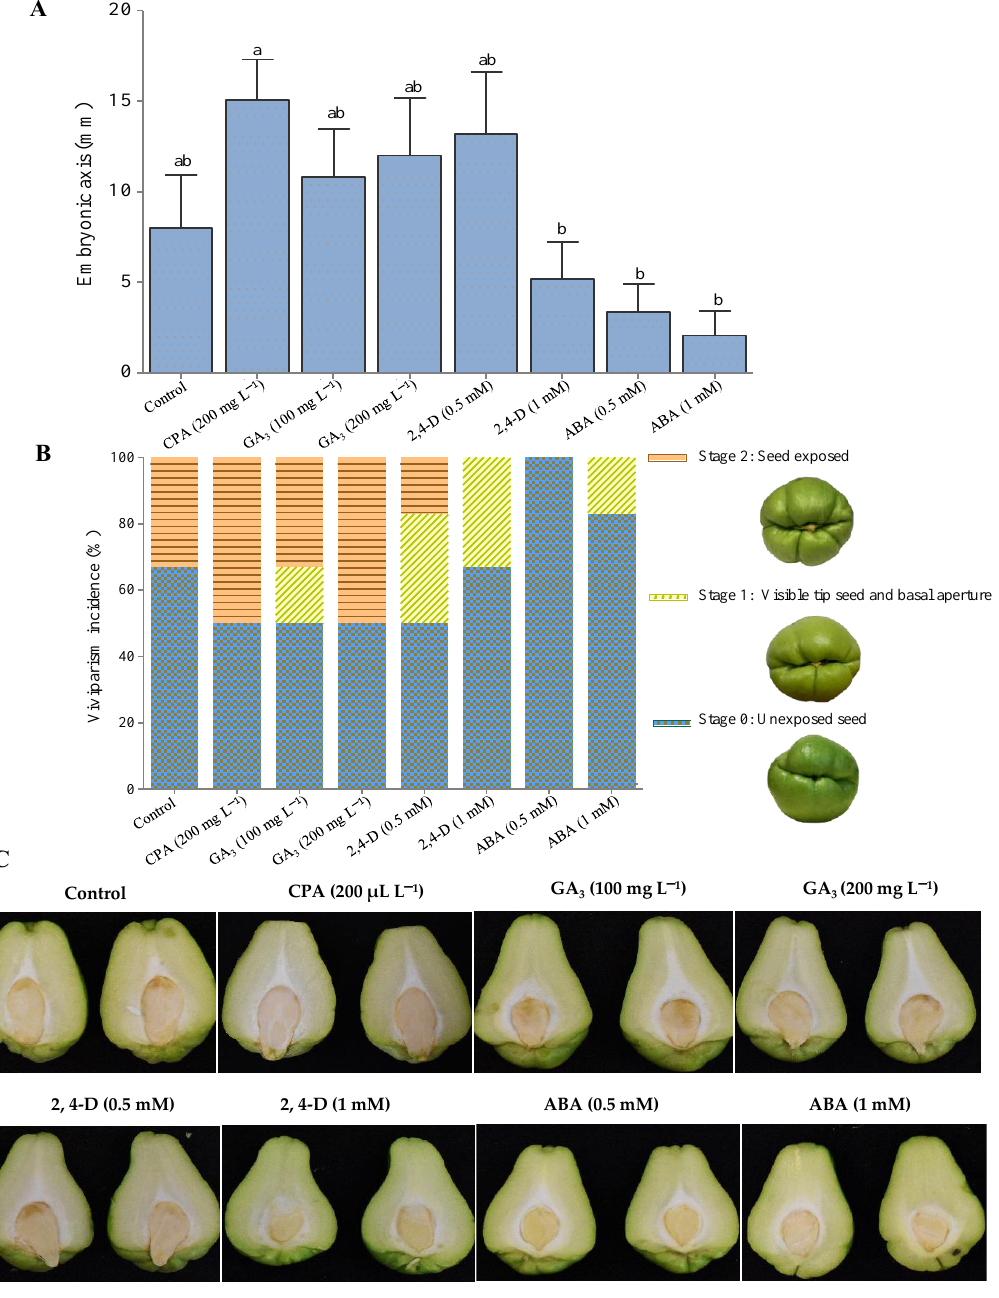
Figure 7. Embryonic axis growth ( A ) and viviparism incidence ( B ) in Sechium edule var. virens levis fruits after 13 days of storage at 24 °C and 65 ± 1% RH, following treatment with growth regulators ( C ): Control (distilled water); 2-chloroethyl phosphonic acid (CPA, 200 µL L −1 ); gibberellic acid 3 (GA 3 , 100 mg L − 1 ); GA 3 (200 mg L − 1 ); 2,4–dichlorophenoxyacetic (2,4-D, 0.5 and 1 mM); abscisic acid (ABA, 0.5 and 1 mM). n = 6 ± standard deviation. Different letters show significant differences (Tukey test, α =